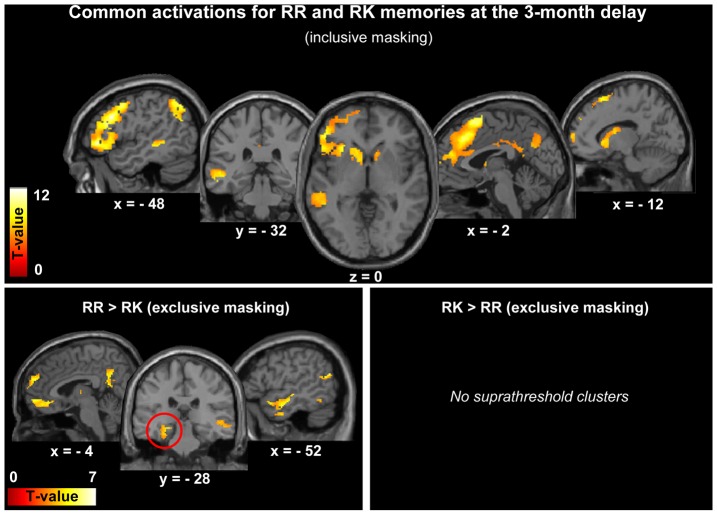
Common and specific activations for RR and RK memories, 3 months after encoding.Common activations (top) are displayed at p<0.05 (FWE corrected) and specific activations (bottom) at p<0.001 (uncorrected), on axial, sagittal and coronal slices of the MNI template. The red circle illustrates the specific activation of the hippocampus for RR memories.